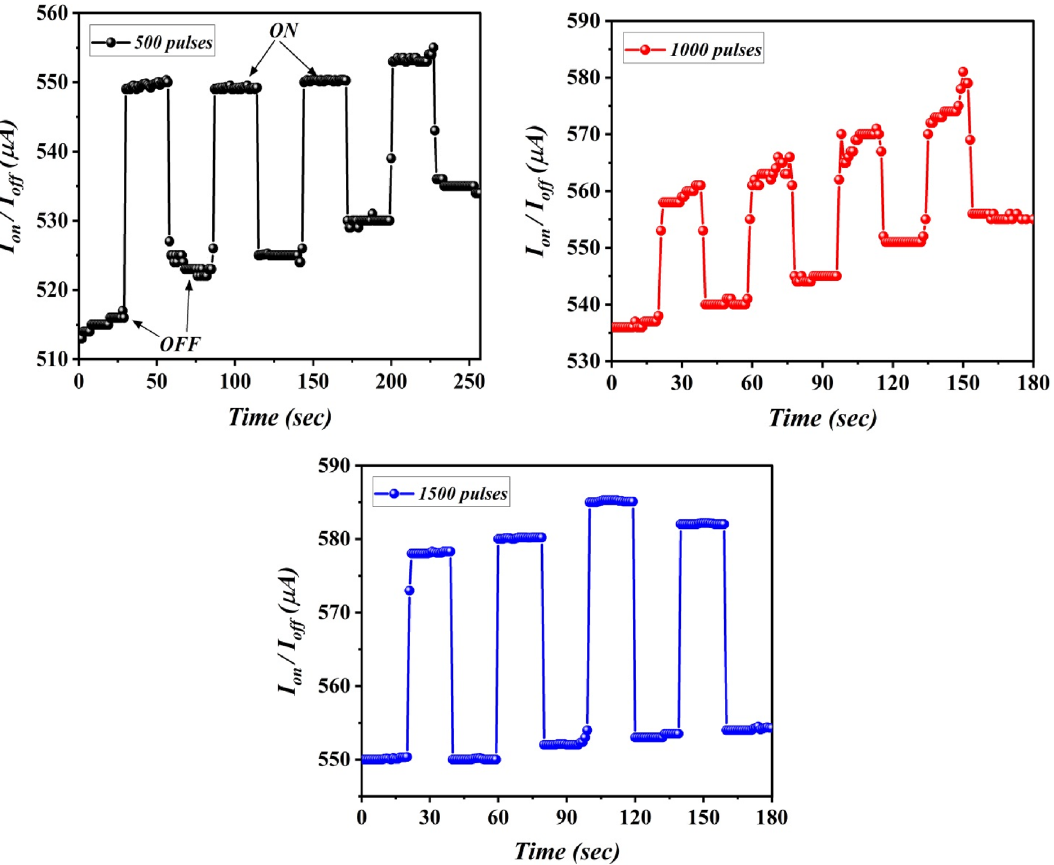
Figure 18. I–t curves of B 4 C/p-Si photodetectors fabricated at different number of laser pulses with response/ recovery time.